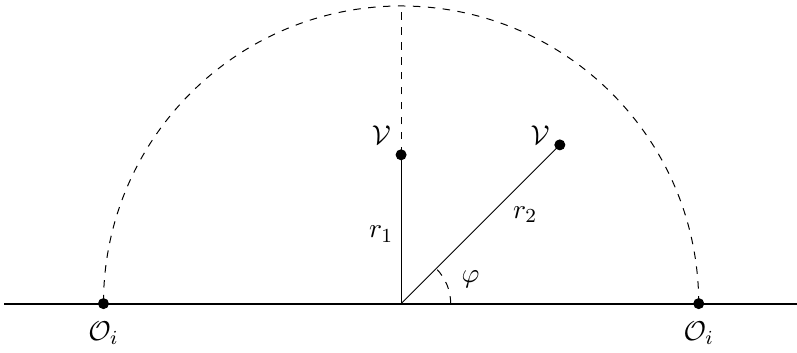
Figure 39. The configuration which defines the ρ -coordinates. The largest dashed semicircle has unit radius. Notice that an isometry can be used to place one of the bulk operators perpendicularly above the middle point between the boundary operators, without displacing the latter. Furthermore, using an inversion one can set r 1 1 <